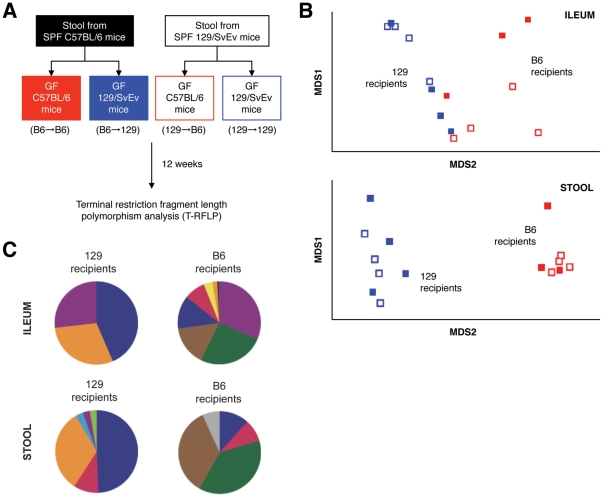
Host genotype affects the composition of intestinal microbiota.(A) 4 experimental groups were defined by colonizing GF B6 or 129 mice with the stool microbiota of SPF B6 or 129 mice (Donor→Recipient). Ileal mucosa and stool bacterial communities were analyzed by T-RFLP at 12 wk post-colonization. (B) TRFs derived from these communities were used to generate nonmetric multidimensional scaling plots for ileal tissue and stool samples. In both bacterial compartments, the 129 (blue) and B6 (red) recipient groups were statistically dissimilar based on ANOSIM analysis (P<.05, n = 3–4 mice/group). (C) Percent contribution of T-RFs to each group (top 100% for ILEUM, top 90% for STOOL). Each color represents a unique T-RF indicating a putative bacterial group.